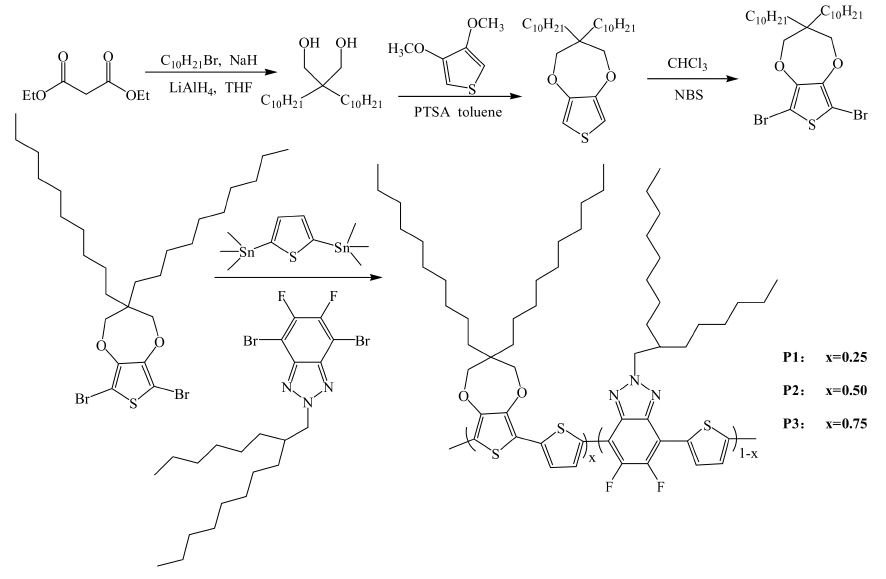
Scheme 1. Synthesis steps of monomers and polymer P1 , P2 and P3